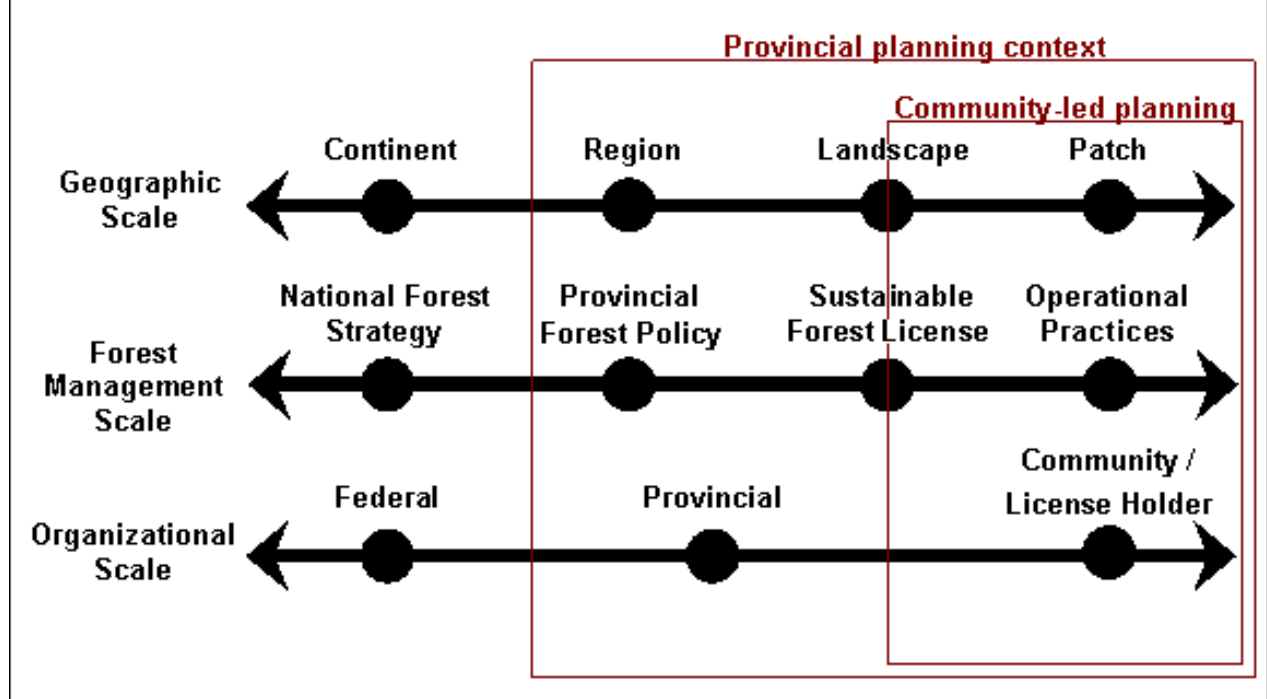
Fig. 2. The cross-scale planning context for forestry in Ontario enabled through the community-based land-use planning policy: the scales represent aspects of forest management planning, and the boxes show the levels on each scale that are addressed by the Province (OMNR) and the levels shared with the community